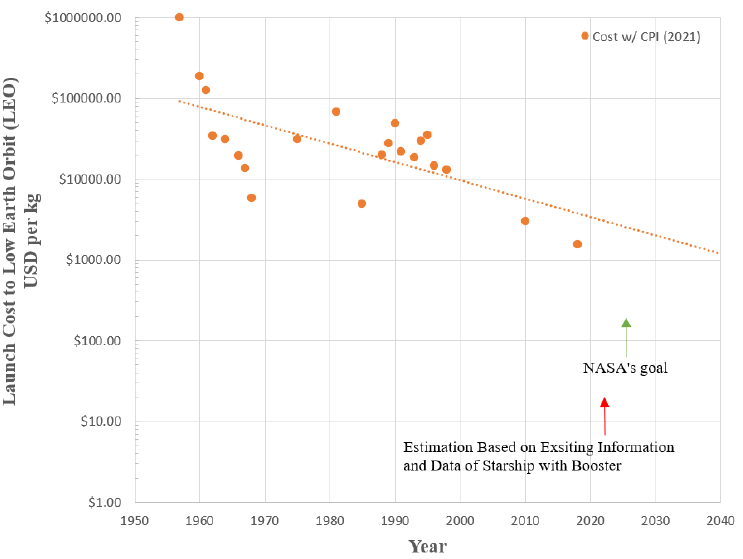
Figure 5. Low earth orbit launch cost change over time with 2021 CPI